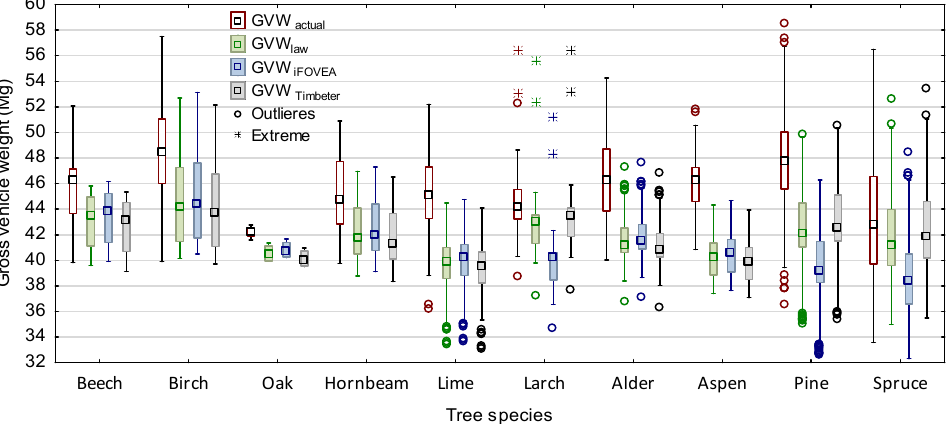
Figure 10. Comparison of the real total gross vehicle weight of transport sets for S2 wood loads with those established by law and the method of measuring wood volumes by species.